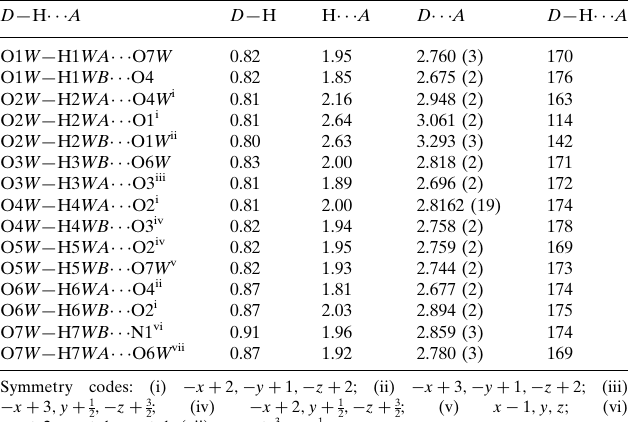
The dinuclear complex in the title compound, Two delocalized carboxylate groups are each connected in a